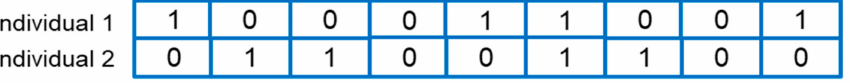
Figure 3. Individual gene coding in genetic